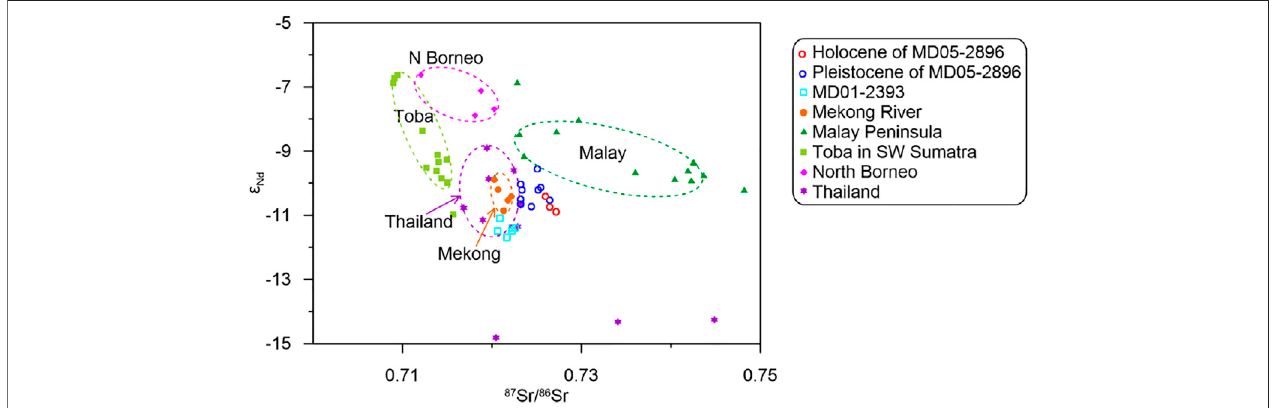
FIGURE 7 | Correlation between ε Nd and 87 Sr/ 86 Sr isotopic compositions. The sediment samples of Core MD05-2896 are divided between the Holocene and the Pleistocene.SurroundingriversamplesintheMekongRiver(Liuetal.,2007a),theMalayPeninsulaandThailand(WuK.etal.,2021;Liuetal.,unpublished),NorthBorneo (Liu et al., 2016), Toba-volcanic rocks in Southwest Sumatra (Chesner, 2012; Lai et al., 2021) for potential sediment sources and sediment samples at referred Core MD01-2393 (Liu et al., 2005) are plotted for comparison.